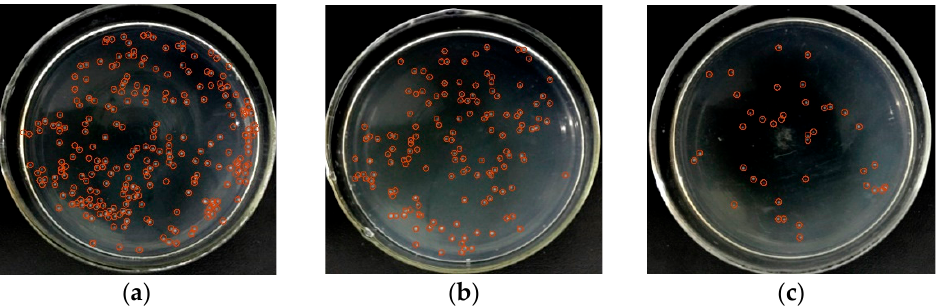
Figure 3. The activated interdigitated electrode enables efficient lysis of bacteria. ( a ) The result of bacteria without voltage. ( b ) When the voltage was 4 V p-p and the frequency was 500 kHz, only a few E. coli were lysed. ( c ) The voltage was increased to 8 V p-p , and the number of colonies was reduced greatly.